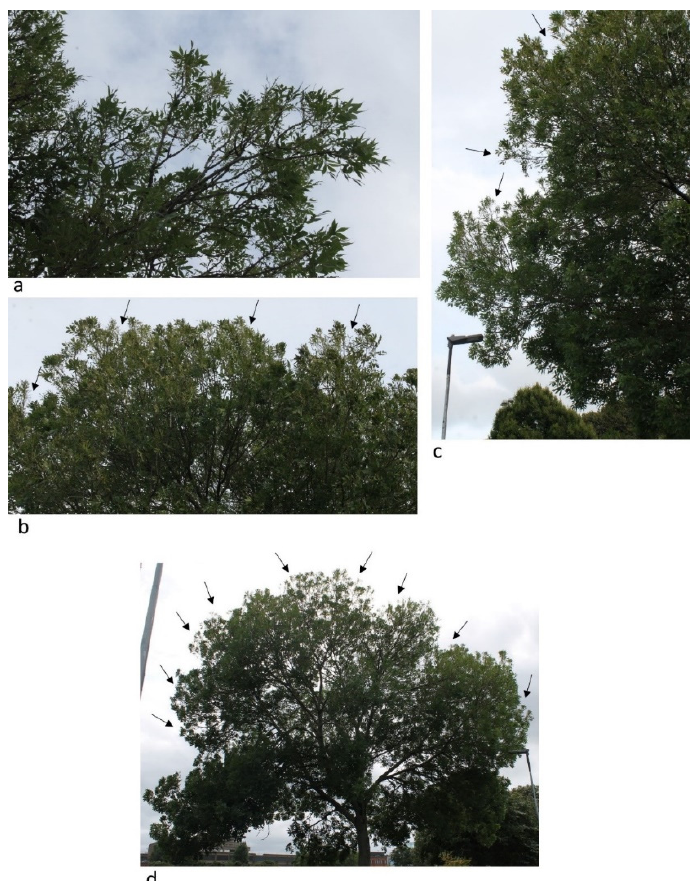
Figure A1. Defoliation of leaves by T. nigritus in Trinity College Dublin, Co. Dublin, Republic of Ireland. ( a – d ). The insect defoliated only the apical leaves of the crown on ( b ) top, ( c ) left and ( d ) right side (indicated in picture by the black arrows) (Trinity College Dublin, Dublin, Ireland, 16.IX.21, photos by E.